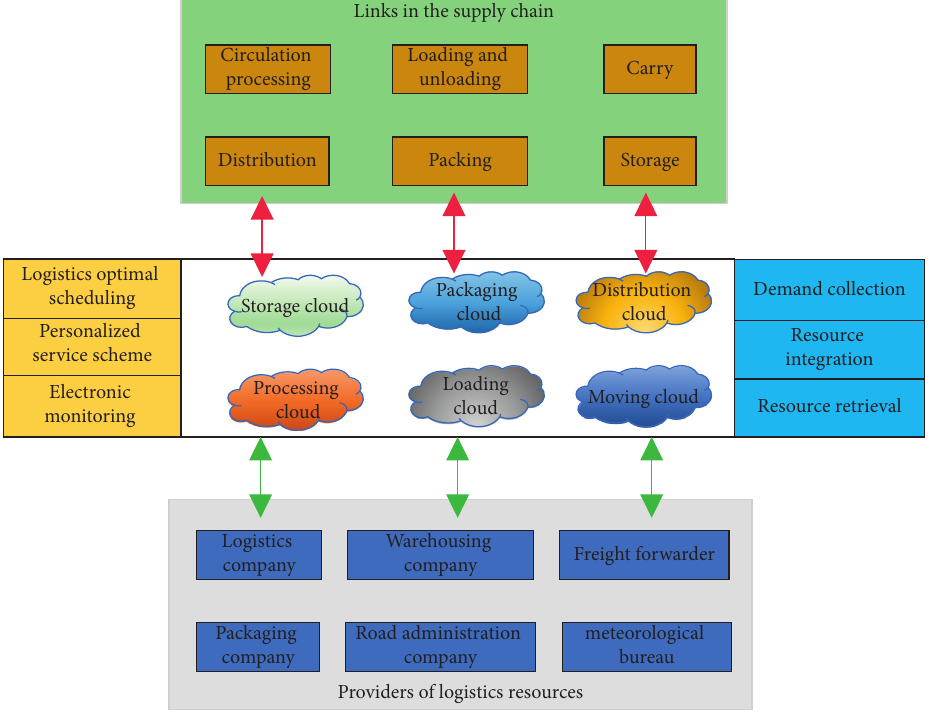
Figure 1: Schematic diagram of composite